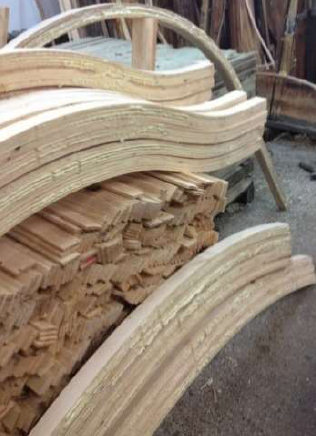
Figure 1. Arches prepared under production conditions.